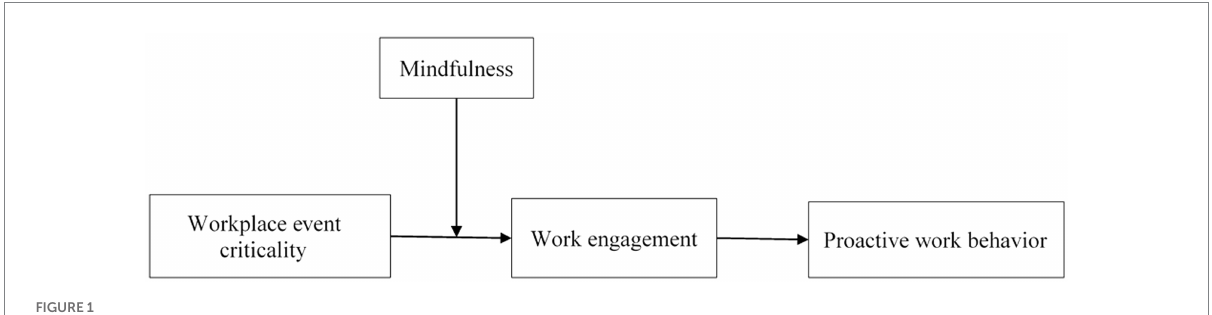
FIGURE 1 Conceptual research